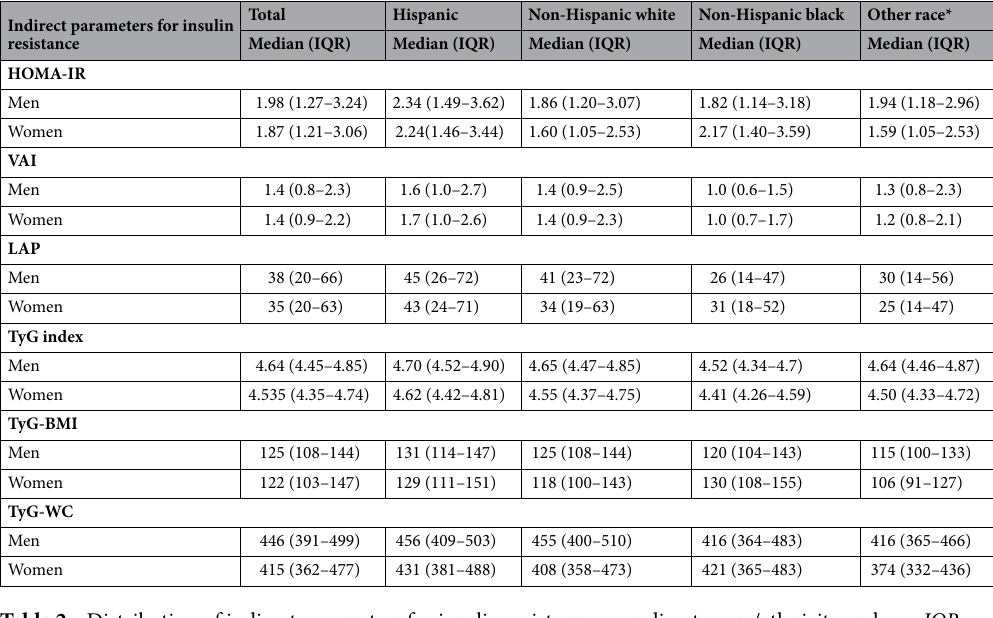
Table 2. Distribution of indirect parameters for insulin resistance according to race/ethnicity and sex. IQR interquartile range, HOMA-IR homeostasis model assessment-insulin resistance, VAI visceral adiposity index, LAP lipid accumulation product, TyG index triglycerides and glucose index, BMI body mass index, WC waist circumference. *Other race included non-Hispanic Asian and multi-racial Americans.